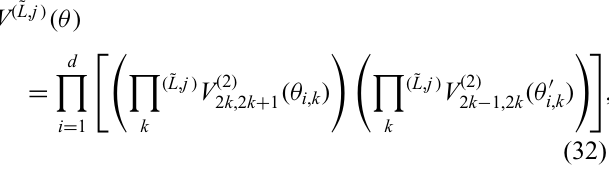
FIG. 4. (a) A diagrammatic description of Tr ((cid:7) j ρ AB ( U ( L ( j ) ( U ( L ) , V ( L ) ) via Proposition 2. (b) Part of the gates composing Tr ((cid:7) C LHST the orange two-qubit gates in V ( L ) † are active, while the other gray and white two-qubit gates vanish due to their positions being out of the causal cones. (c) A schematic picture of the active region in the ansatz V ( L ) . All the active two-qubit gates are included in the yellow domain. Its height determines the proper compilation size ˜ L